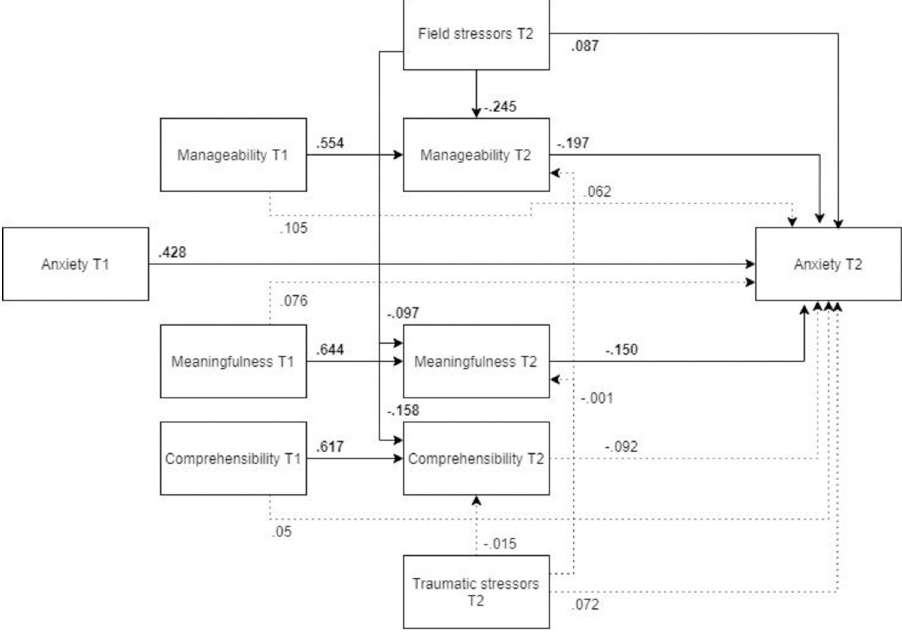
Fig 2. Tested structural equation model for anxiety.